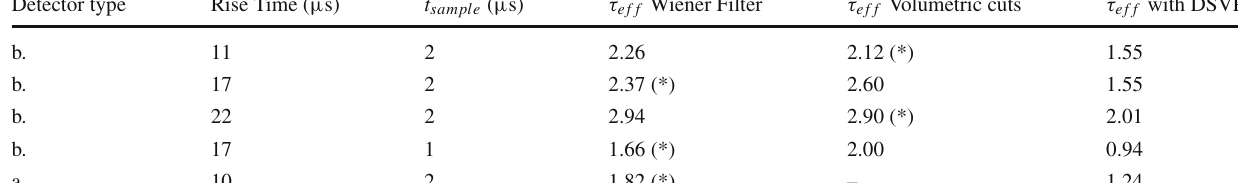
Table 1 Effective time resolution of the DSVP with Wiener Filter and Volumetric cuts. We indicated with (*) the algorithm used in that simu- lation to lower the ratio of f ROI pp